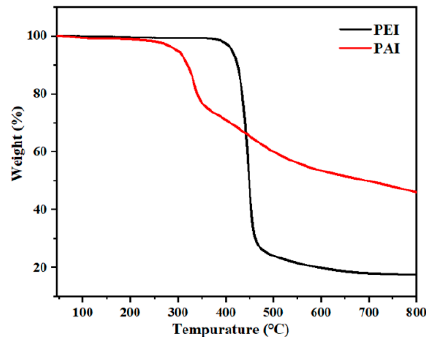
Figure 5. TGA curves of PEI and polyamide-imide (PAI).